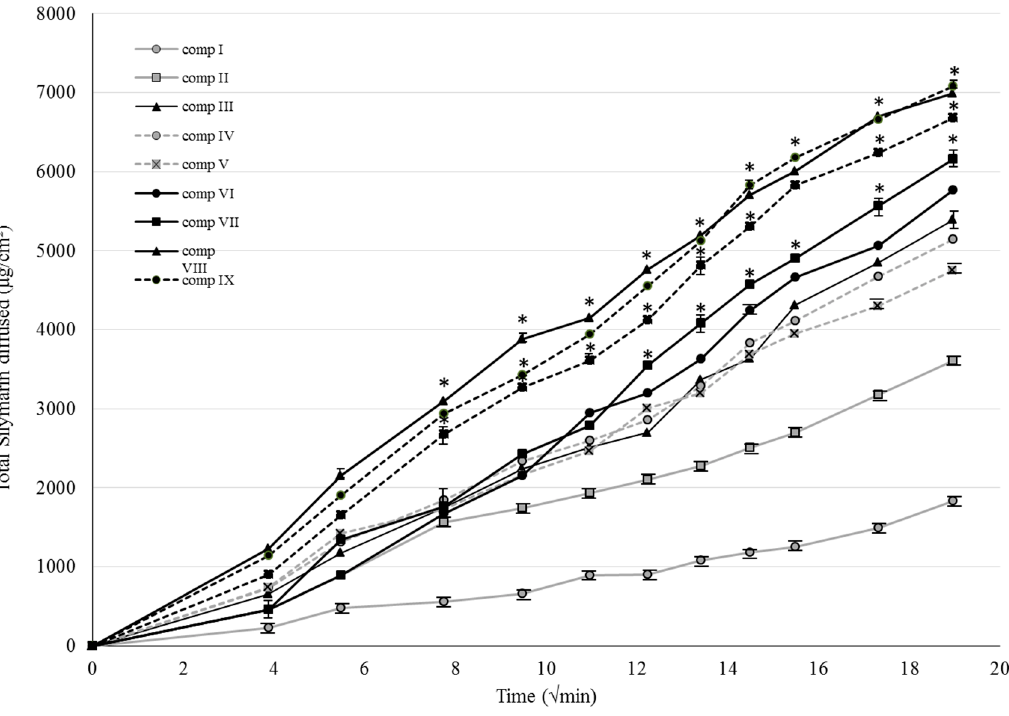
Figure 2. Release profiles of SM across isopropyl myristate (IPM) impregnated cellulose-acetate membrane of the formulations I–X. Each point represents the mean ± S.D. of five experiments. Repeated-Measures Anova and Pearson correlation tests were performed. Significant differences ( p > 0.05) were marked with * in the figure. The asterisks show the significance levels in the case of compositions containing SM in suspended or dissolved forms. Table 2. Silymarin release rate and the diffusion coefficient values of the compositions (I–X). Each data point represents the mean ± S.D., n = 5, p > 0.05. Repeated-Measures Anova and Pearson correlation tests were performed. Significant differences are marked with * in the table. * show the significance levels in the case of compositions containing SM in suspended or dissolved forms.